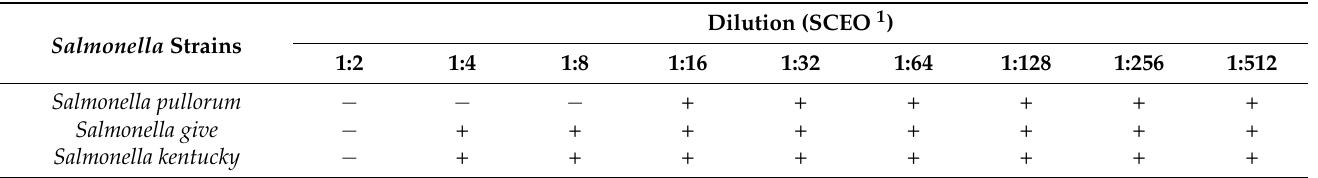
Table 1. MIC of SCEO.